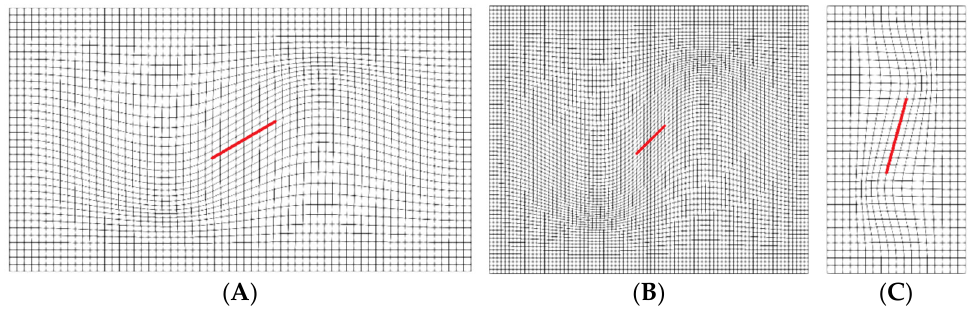
Figure 4. Examples of structured curvilinear meshes around fractures for different fracture inclination angles: ( A ) 30°; ( B ) 45°; ( C ) 75°.